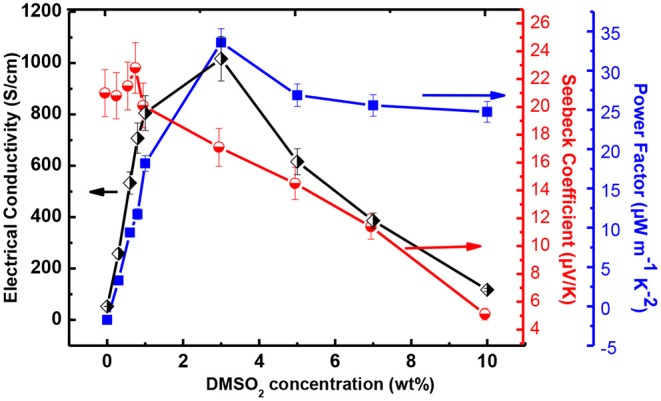
The electrical conductivity, Seebeck coefficient and power factor at ambient temperature for DMSO2 doped PEDOT:PSS at different loading.